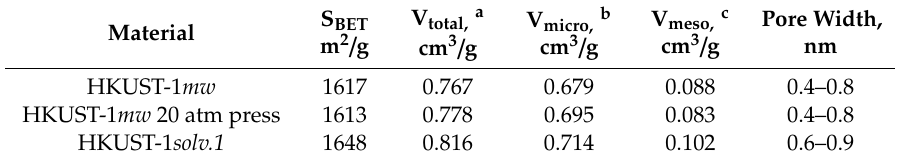
Table 2. Textural characteristics of the HKUST-1 mw , HKUST-1 mw press and HKUST-1 solv.1 samples.